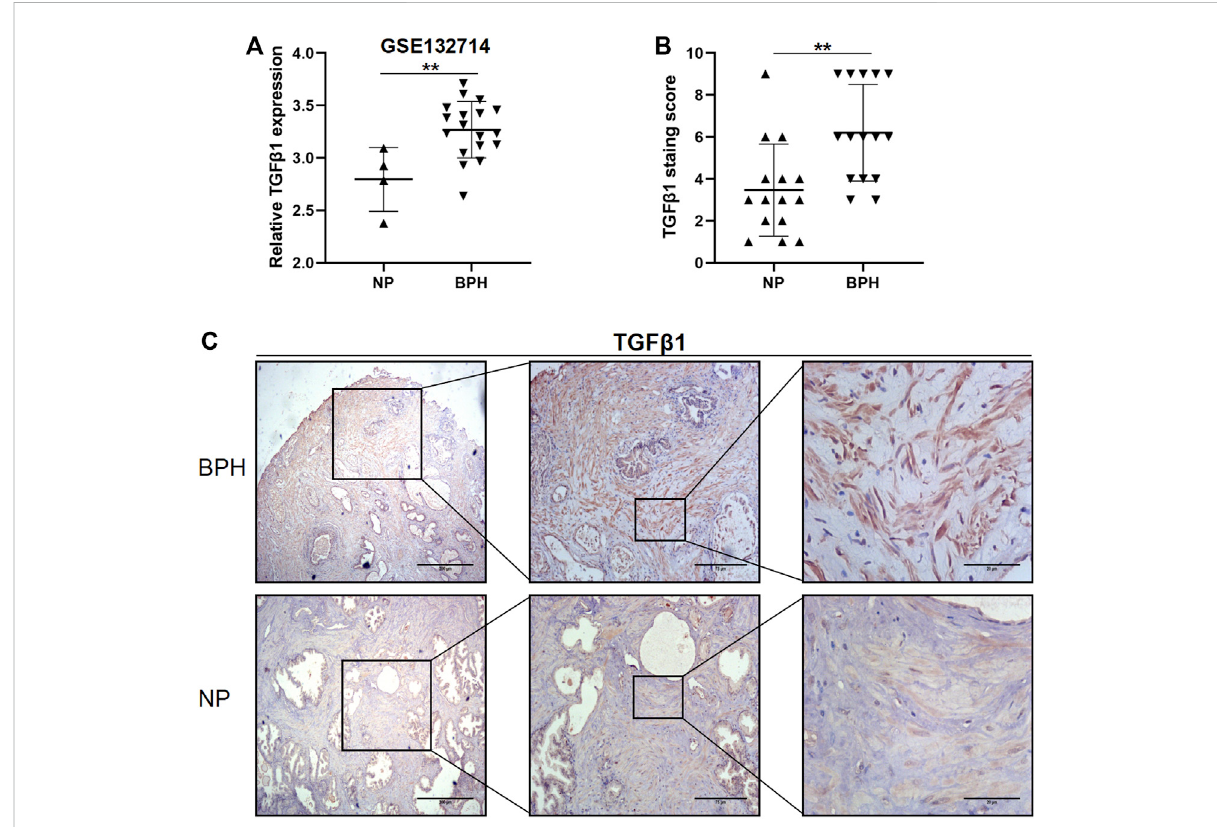
FIGURE 1 TGF β 1 is strongly upregulated in benign prostatic hyperplasia (BPH) compared with normal prostate (NP). (A) Expression levels of TGF β 1 mRNA between BPH and NP in the GSE132714 data set. ** p < 0.01. (B) Expression levels of TGF β 1 protein in BPH and NP tissues. Protein expression